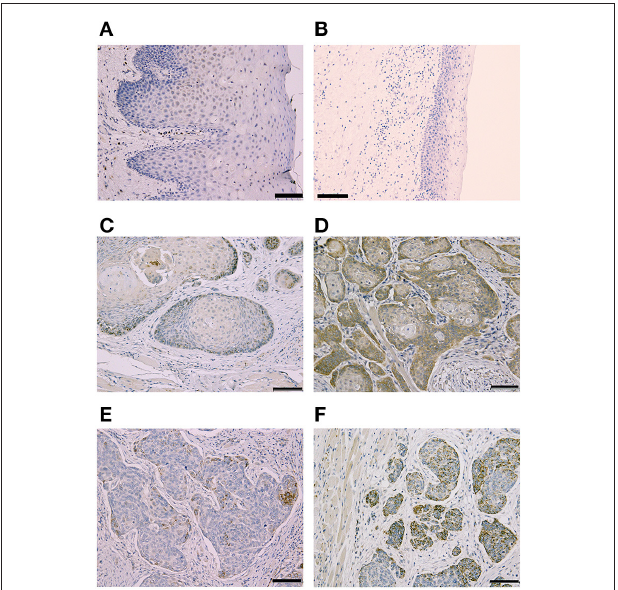
FIGURE 1 | Representative Immunohistochemical staining according to Cleft Lip and Palate Transmembrane 1-Like (Clptm1L) and TMEM207 immunoreactivity at the invasion front of oral squamous cell carcinoma (OSCC). Weak Clptm1L or TMEM207 immunoreactivity was found in non-tumorous oral epithelial cells (A,B) , respectively. In contrast, Clptm1L or TMEM207 immunoreactivity was found in many invasive OSCC cells. Representative positive Clptm1L immunoreactivity in tissue specimens from patients with favorable and poor prognosis is shown in (C,D) , respectively. TMEM207 immunoreactivity in tissue specimens from patients with favorable and poor prognosis is shown in (E,F) , respectively. Note the robust Clptm1L and TMEM207 immunoreactivity in (D,F) .